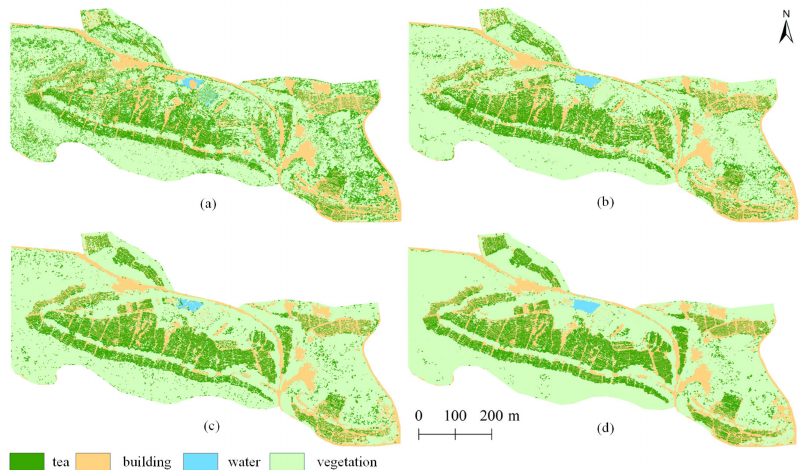
Figure 11. The classification results derived from the four models using SVM. ( a ) Model 1; ( b ) Model 2; ( c ) Model 3; ( d ) Model